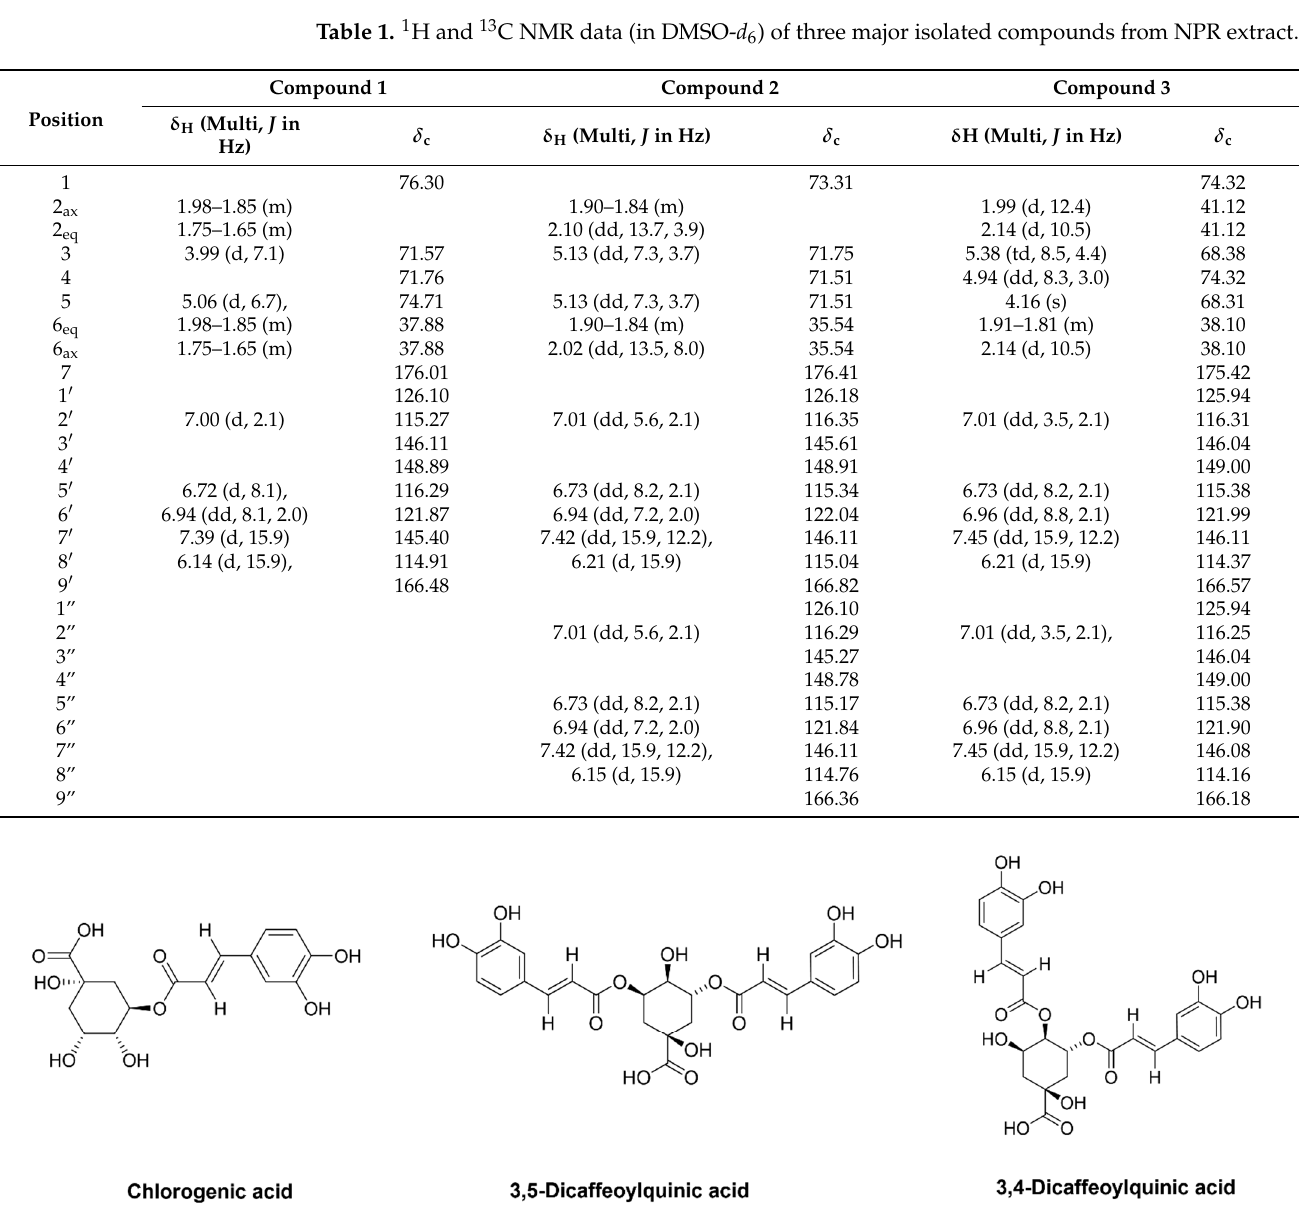
Figure 8. HPLC-PDA chromatogram of NPR extract at 325 nm. ( 1 ) Chlorogenic acid, ( 2 ) 3,5- Dica ff eoylquinic acid, and ( 3 ) 3,4-Dica ff eoylquinic acid. 4. Discussion Extracts of plant parts contain di ff erent metabolites and have signi fi cantly di ff erent activities [30,31]; thus, researchers in the medicinal and pharmaceutical fi elds tend to in- vestigate the activities of speci fi c parts. In recent years, plants and their extracts have emerged as alternative treatments for acute and chronic diseases, including AD [32,33]. Furthermore, numerous human clinical studies have demonstrated plant extracts and herbal products to have anti-AD e ff ects and no noticeable side e ff ects [33]. N. peltata is an aquatic perennial and a valuable medicinal herb in Ayurvedic medicine [20]. Although N. peltata extracts have been reported to possess signi fi cant anti-in fl ammatory, anti-tumor, and anti-wrinkle e ff ects [19,25,26], no previous study has examined its anti-AD e ff ect. Our present study showed that the extracts of whole N. peltata extract and its aerial and root